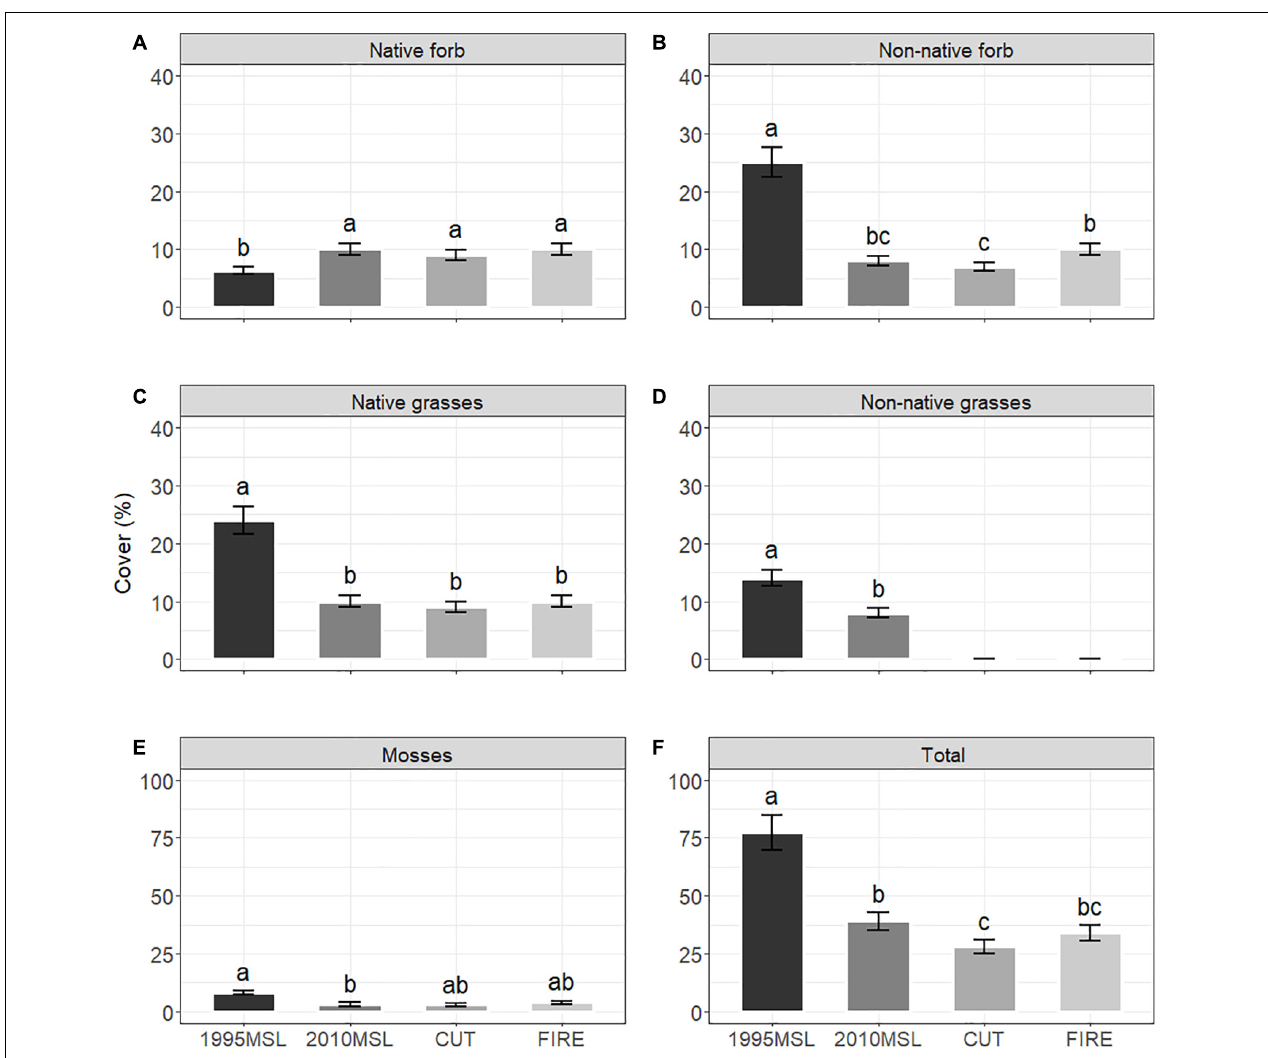
FIGURE 2 | Least squares means (lsmeans) of coverages of native and non-native forbs (A,B) , native and non-native grasses (C,D) , mosses (E) , and total (F) layer by reclaimed (1995 and 2010MSL) and reference (CUT and FIRE) site types. Mean ( ± SE) values with a different lowercase letter(s) were significantly different among the site types at P <